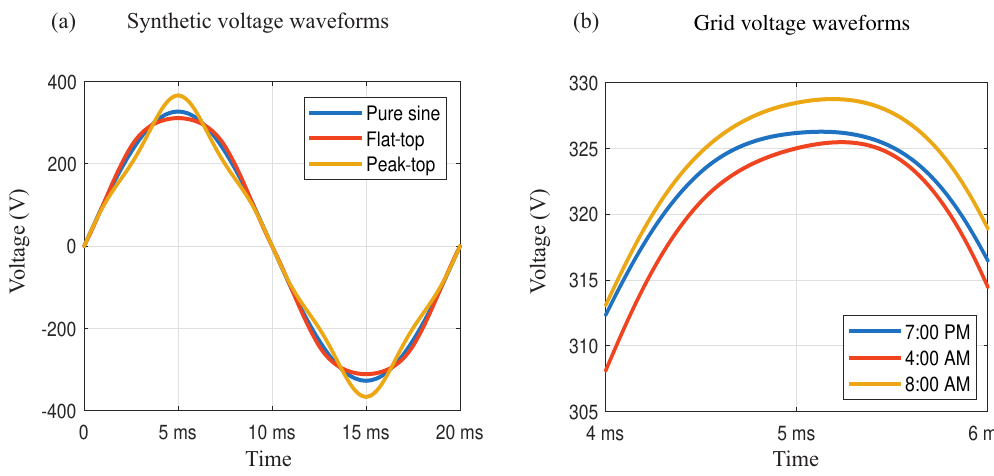
Fig. 6. Voltage waveforms used for current harmonics